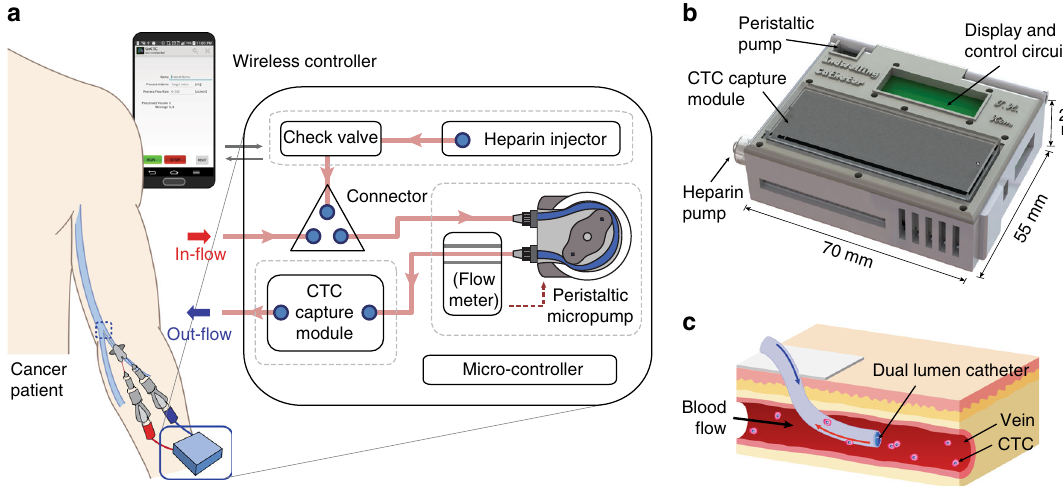
Fig. 1 The in vivo aphaeretic CTC isolation system. a , b Schematic overview of the indwelling intravenous system by functional components ( a ) and manifold ( b ). c Application of a dual lumen catheter for in vivo CTC